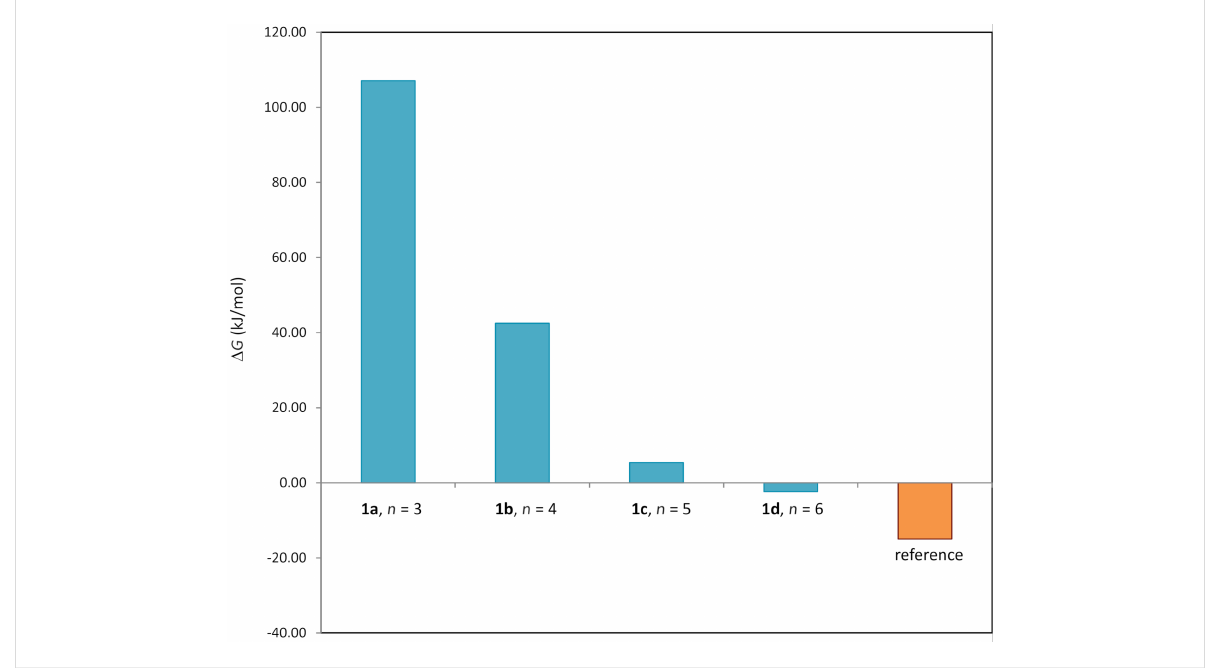
Figure 3: Gibbs free energy differences ( Δ G ) between Z - and E -isomers of 1a – d and of the reference compound 7 calculated using B3LYP. The results show a pronounced effect of linker length on the energy difference between Z - and E -isomers.